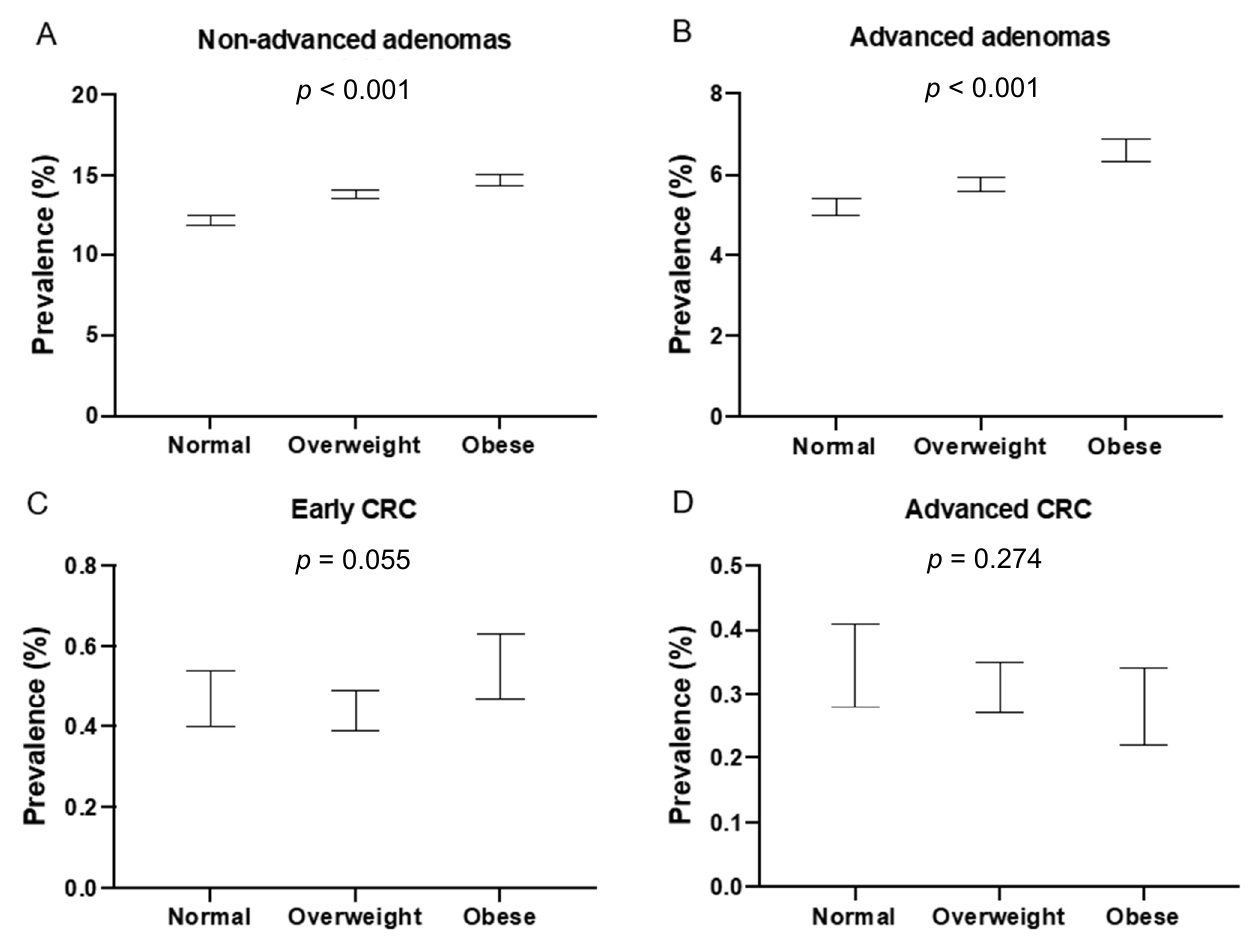
Figure 1. Comparison of adjusted prevalence: ( A ): adjusted prevalence of non-advanced adenoma stratified by BMI categories; ( B ): adjusted prevalence of advanced adenoma stratified by BMI cate- gories; ( C ): adjusted prevalence of early CRC stratified by BMI categories; ( D ) adjusted prevalence of advanced CRC stratified by BMI categories. Error bars represent 95% confidence